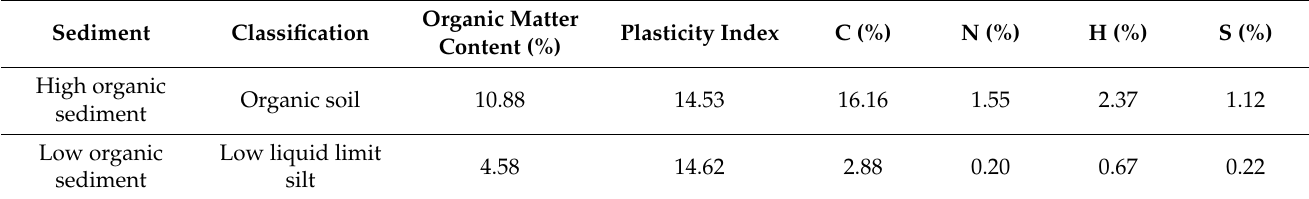
Table 1. Main Physical and Chemical Properties of Tested Sediment.